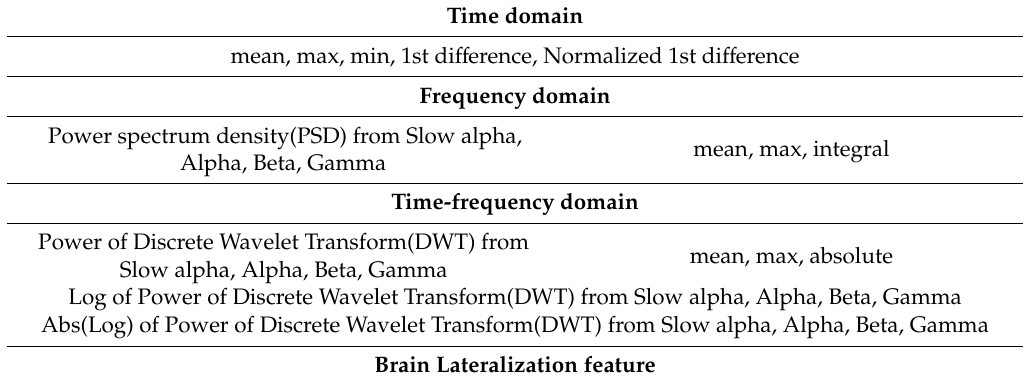
Table 5. EEG feature list for genetic algorithm—long short-term memory (GA-LSTM).